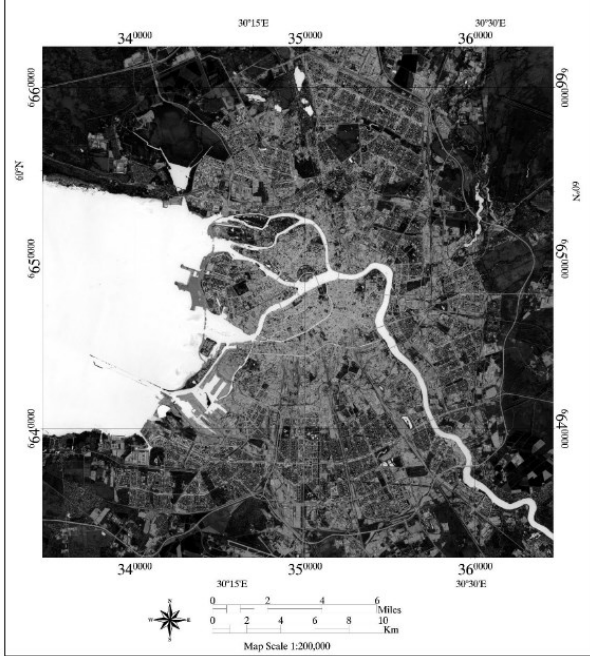
Figure 1. Sentinel 2 image for the study area in St. Petersburg.